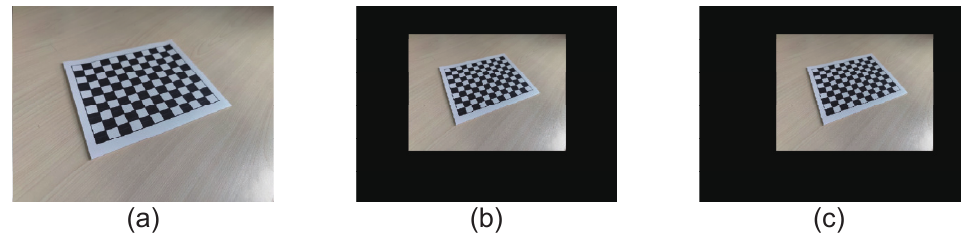
Figure 10. Translation of the image. ( a ) Is the original image, ( b ) is the transformed image obtained by increasing the x axis coordinate of the original image vertex by 50 and ( c ) is the transformed image obtained by reducing the y axis coordinate by 100 on the basis of ( b